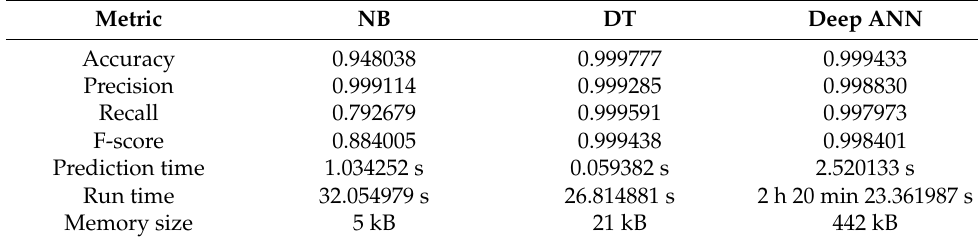
Figure 11. Anomaly detectors’ prediction time (in seconds). Table 12. Metrics for different anomaly detectors (binary